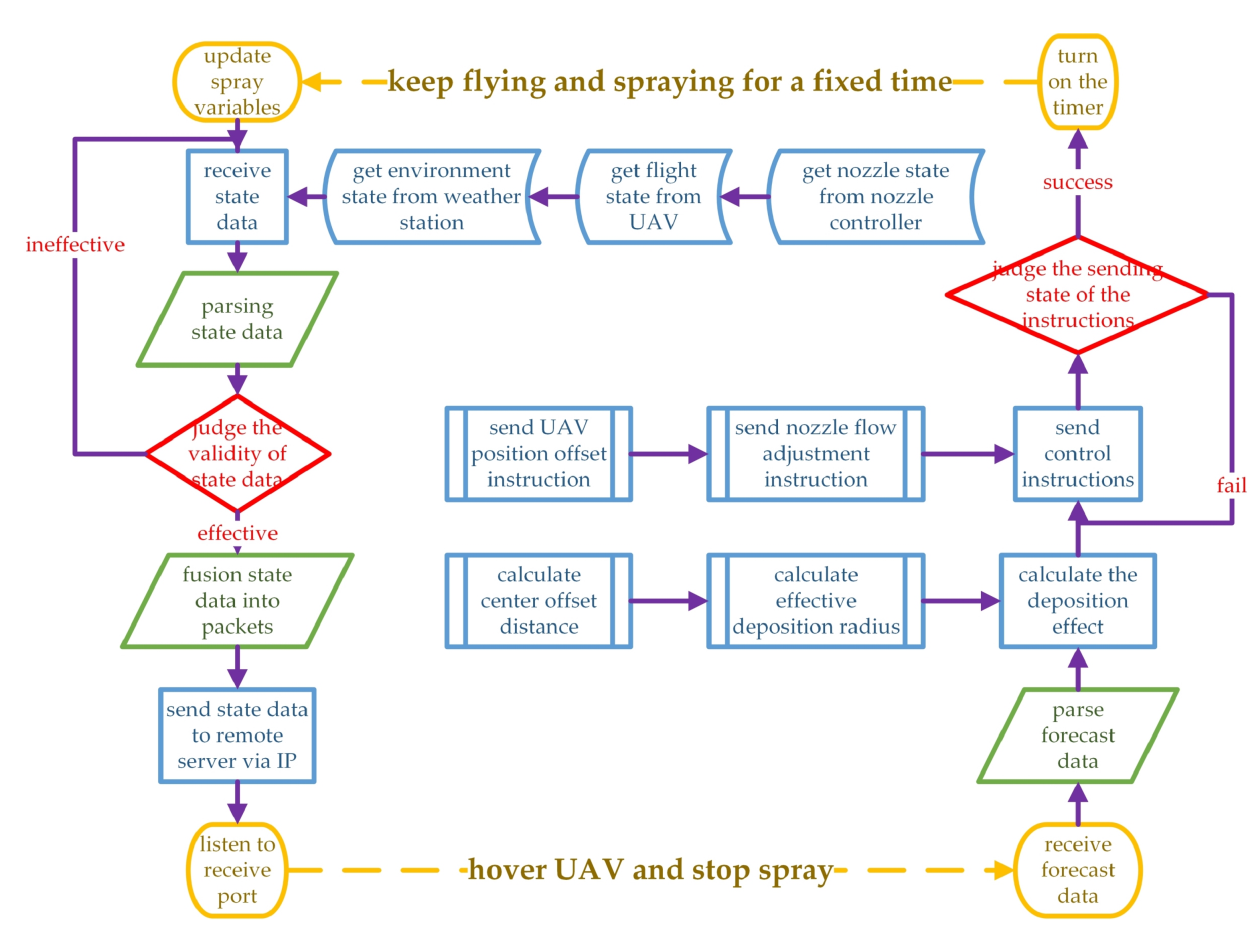
Figure 13. Data receiving, processing, and transmission flow chart of ground station. When the UAV approaches the boundary of the operation area, the ground station starts to work. The ground station receives the state data from three sensor modules and judges the validity. Invalid conditions include low residual power, less residual pesticide, weak signal, bad working environment (wind speed, temperature), and pump